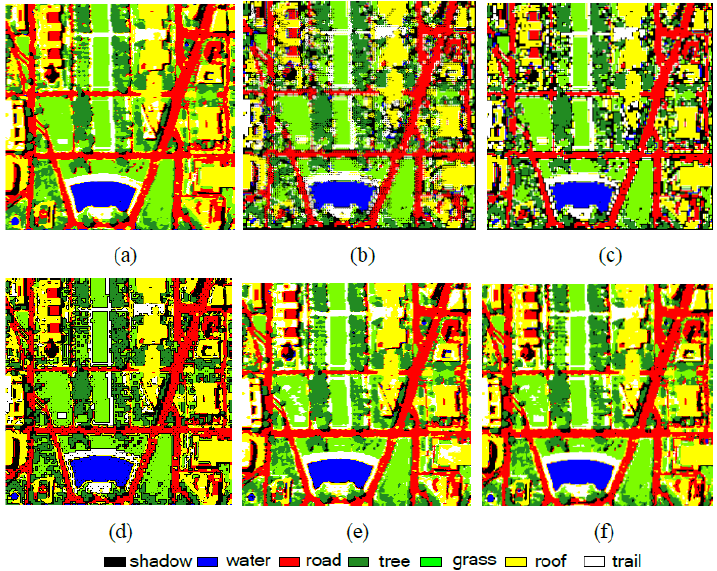
Figure 9. SRTM in experiment 1 ( S = 2). ( a ) Reference image; ( b ) BI result; ( c ) BIC result; ( d ) MAP result; ( e ) MTC result; ( f ) PTC result. Table 1. Super-resolution reconstruction errors for different